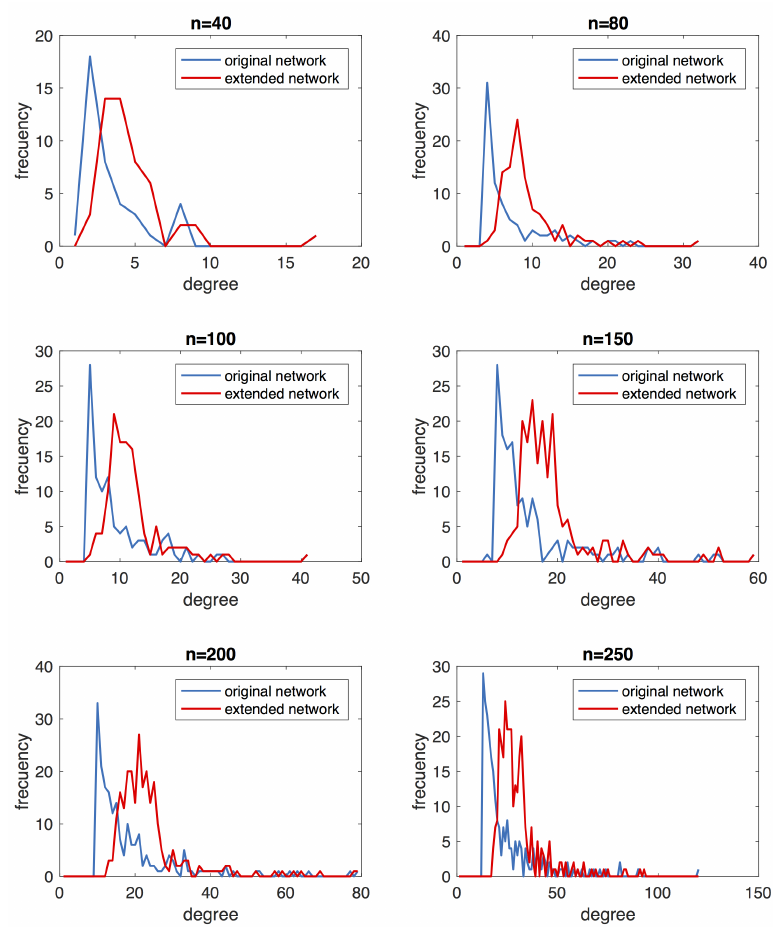
Fig. 3. Frequency plots for point degree with 25% of nodes